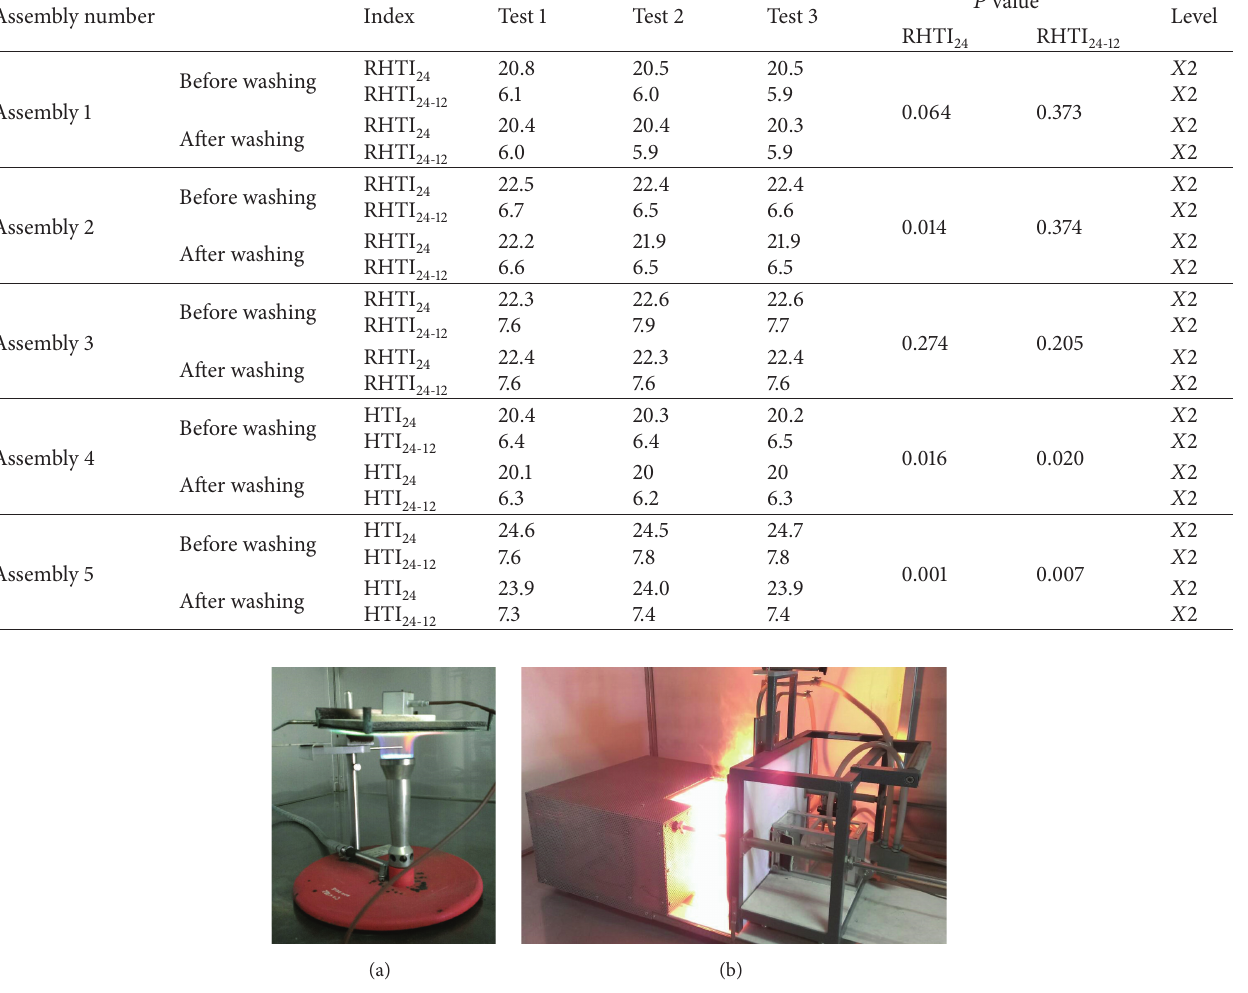
Figure 2: Measurements for thermal protective performance (a) specimen when exposed to flame using WAZAU TPP DIN ISO 9151